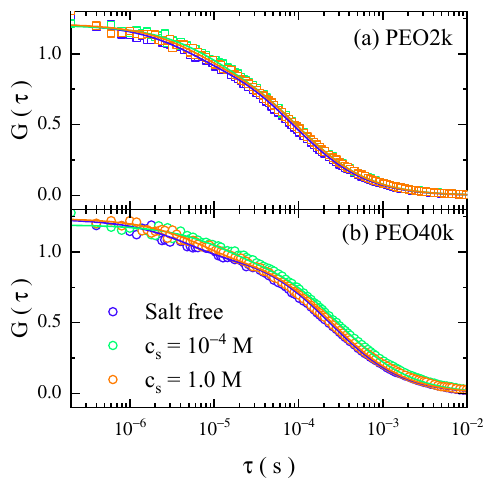
Figure 1. Auto-correlation functions of the fluorescence-labeled ( a ) PEO2k and ( b ) PEO40k in aqueous solutions under different salt concentrations: the salt-free condition, and salt concentrations of 1.0 × 10 − 4 and 1.0 M, respectively. The solid lines denote the result of the numerical fitting using a three-dimensional Brownian motion model. The fast dynamics around 10 − 6 s is due to the triplet state